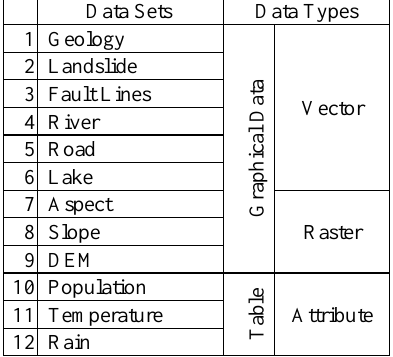
Table 1. Parameters used in the study